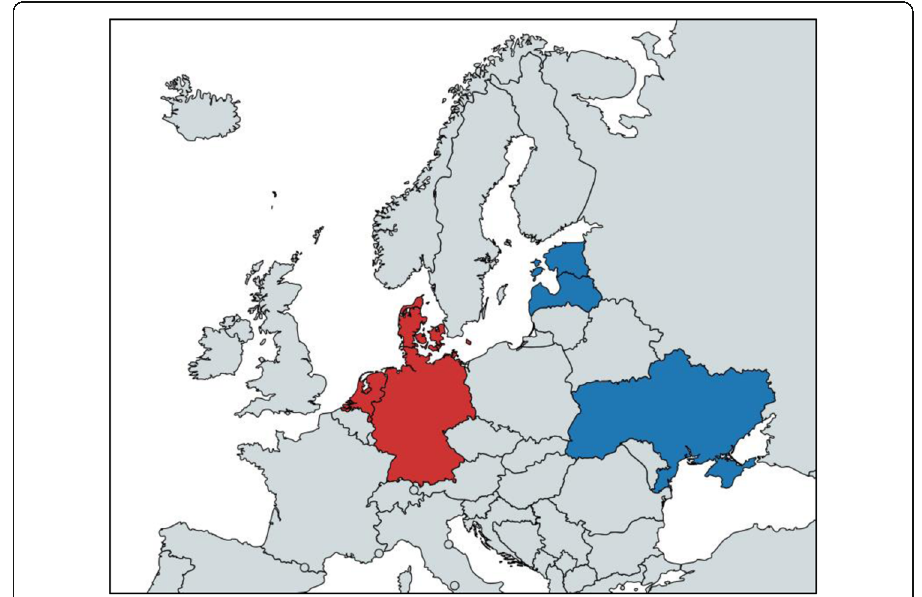
Fig. 1 Russian migrant populations in Western countries and select former Soviet states. Note: The Western countries highlighted in red are Denmark, Germany and the Netherlands. The countries highlighted in blue are Estonia, Latvia, and